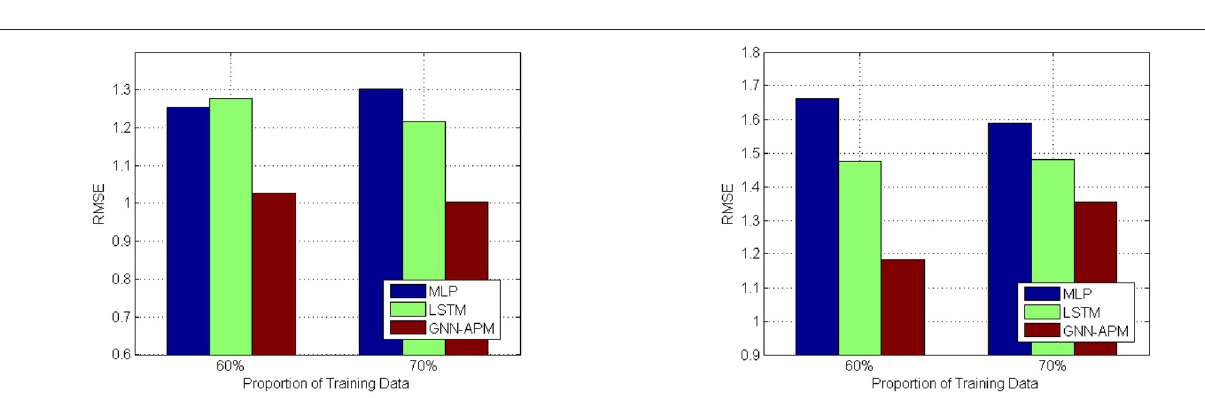
FIGURE 4 | Average mean absolute error (MAE) results under two different learning rate values.